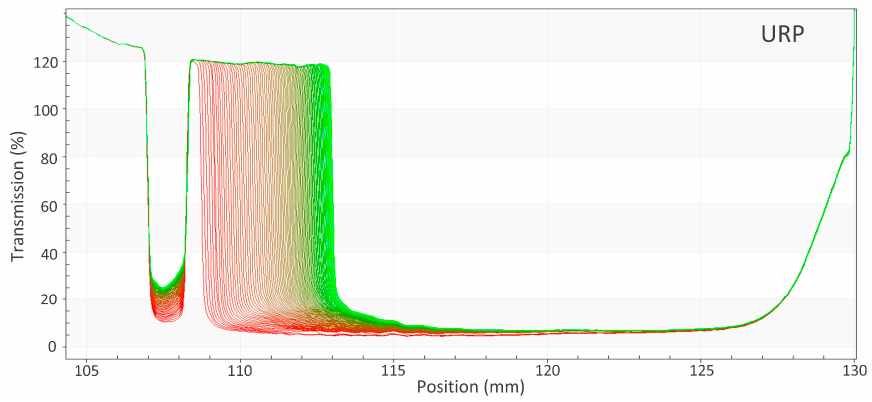
Figure A2. Transmission profiles of the unstable recycled paint, URP (6 h at 300× g ). Profile changes are due to the variation in particle concentration in the sample and also to changes in the size or shape of the particles. The parallel lines at the top of the graph indicate syneresis and/or flocculation [18]. The supernatant appears gradually at the top of the tube leading to total light transmission. The transmission gradient at the bottom of the spectrum is due to the sedimentation of polydisperse particles. The particles do not move at the same velocity depending on their size, with a decrease at high concentrations because of the hindrance [28].